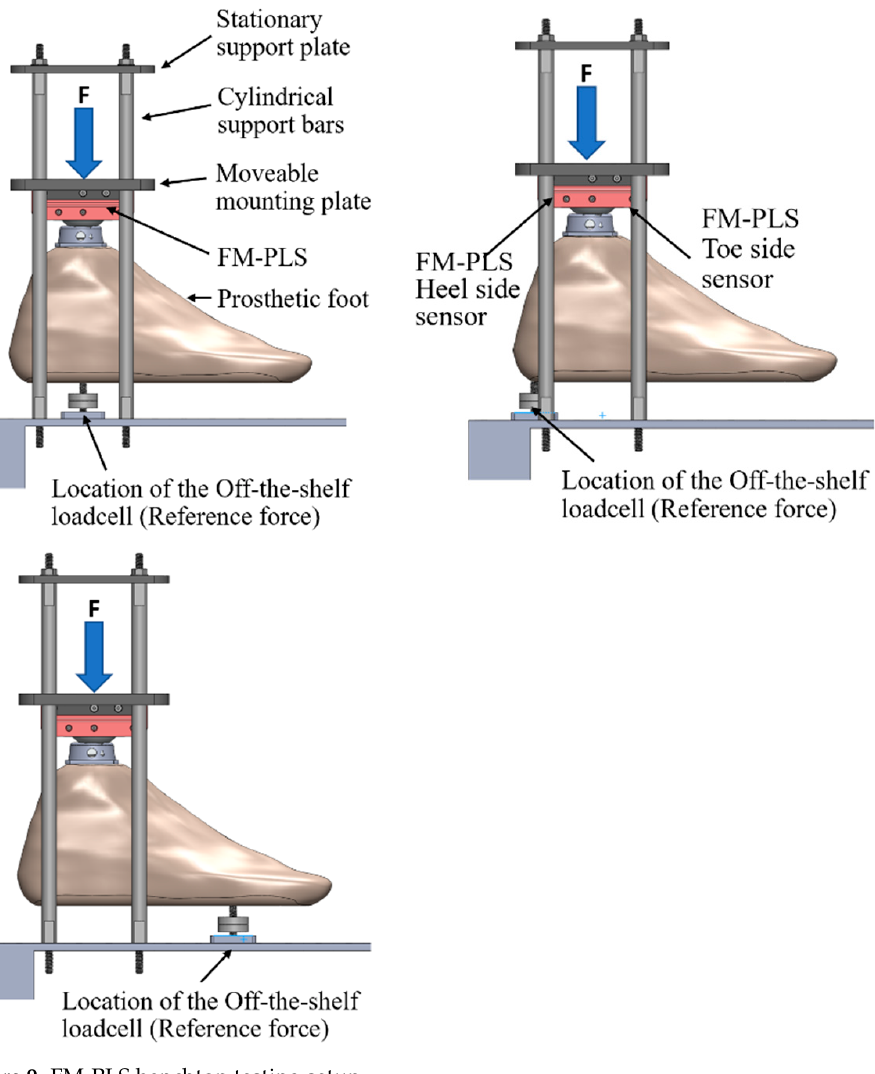
Figure 9. FM-PLS benchtop testing setup.